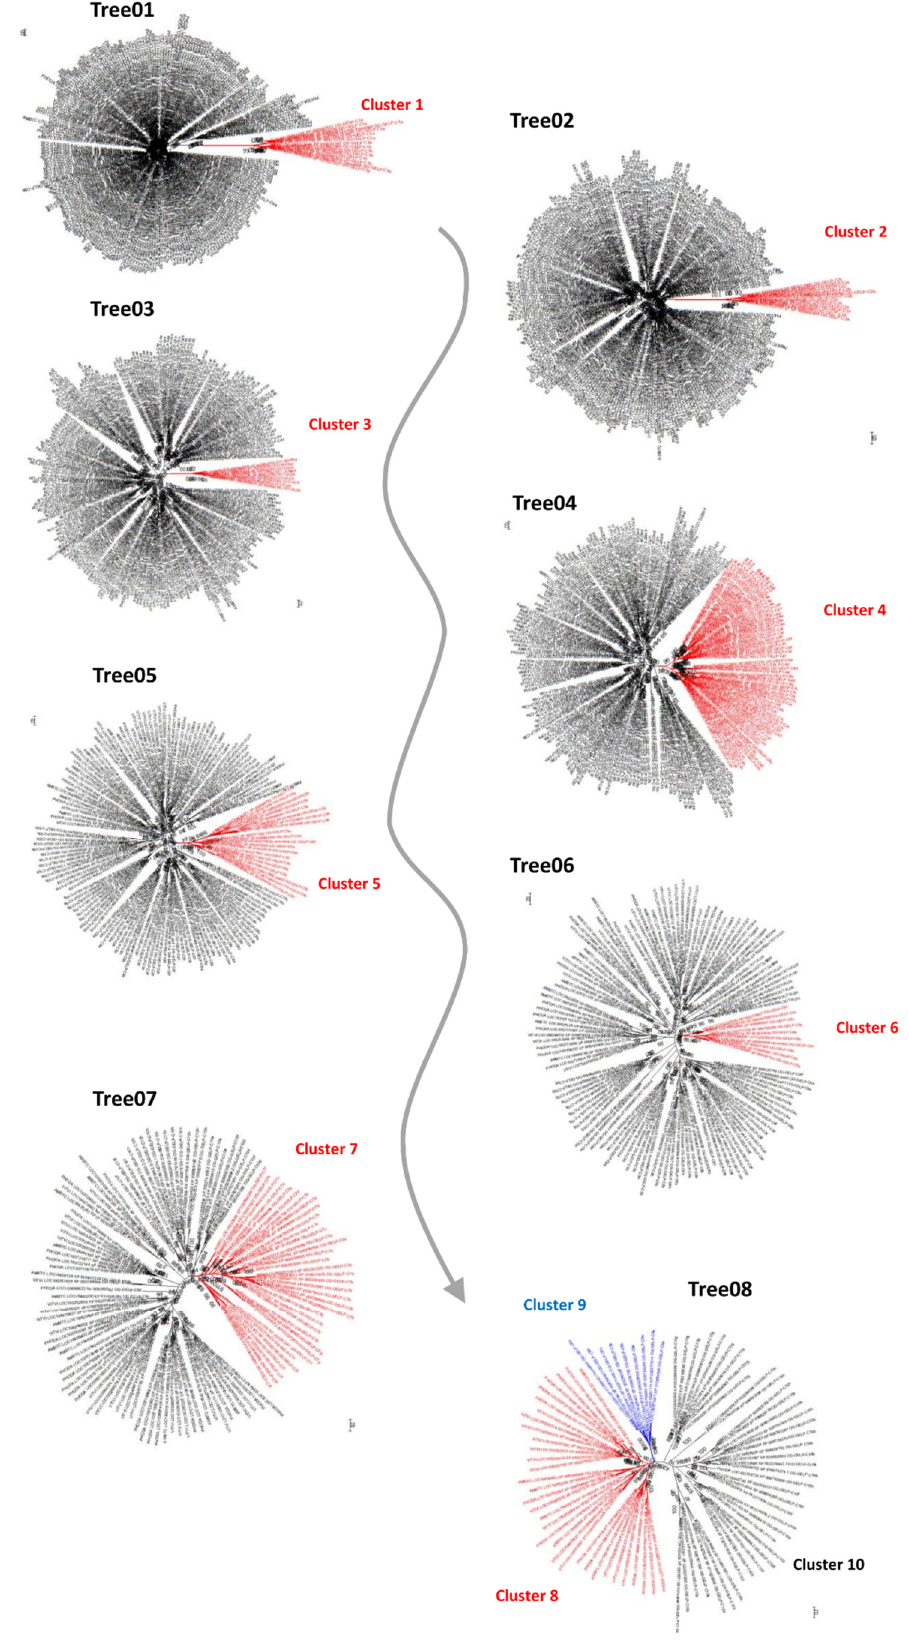
Figure 1. Schematic illustration of the iterative method using unrooted phylogenetic trees to identify the main clusters.